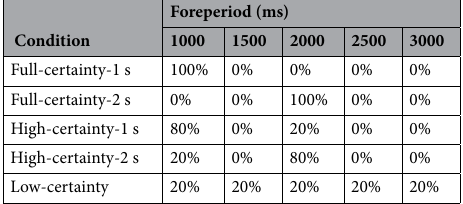
Table 1. Foreperiod distribution across conditions. Percentage of trials of each foreperiod, within a block.